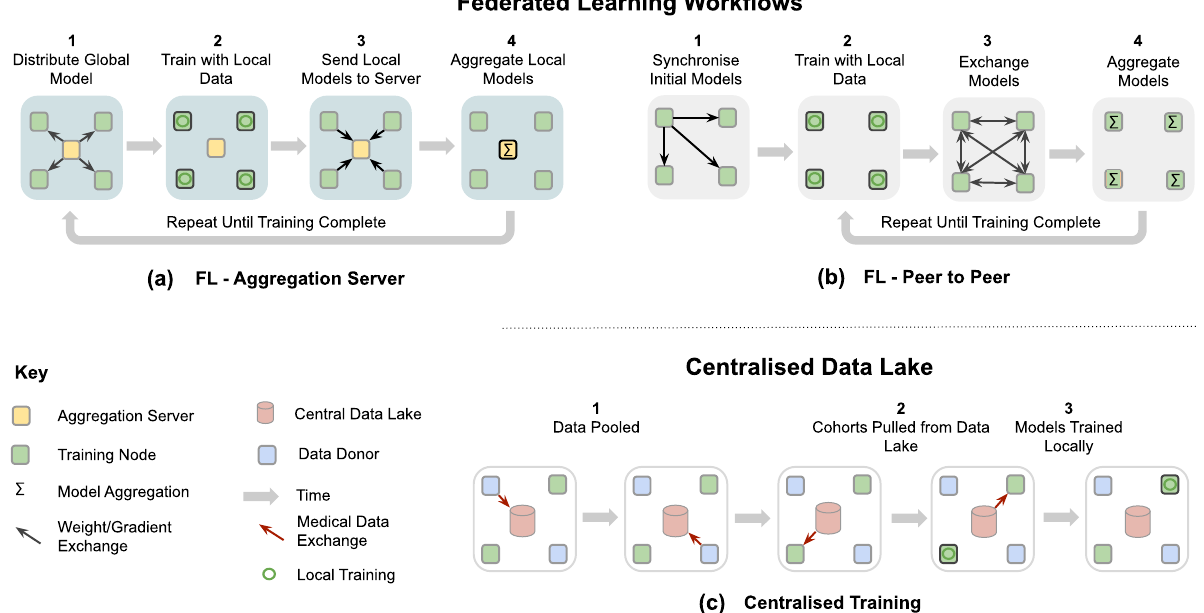
Fig. 1 Example federated learning (FL) work fl ows and difference to learning on a Centralised Data Lake. a FL aggregation server — the typical FL work fl ow in which a federation of training nodes receive the global model, resubmit their partially trained models to a central server intermittently for aggregation and then continue training on the consensus model that the server returns. b FL peer to peer — alternative formulation of FL in which each training node exchanges its partially trained models with some or all of its peers and each does its own aggregation. c Centralised training — the general non-FL training work fl ow in which data acquiring sites donate their data to a central Data Lake from which they and others are able to extract data for local, independent